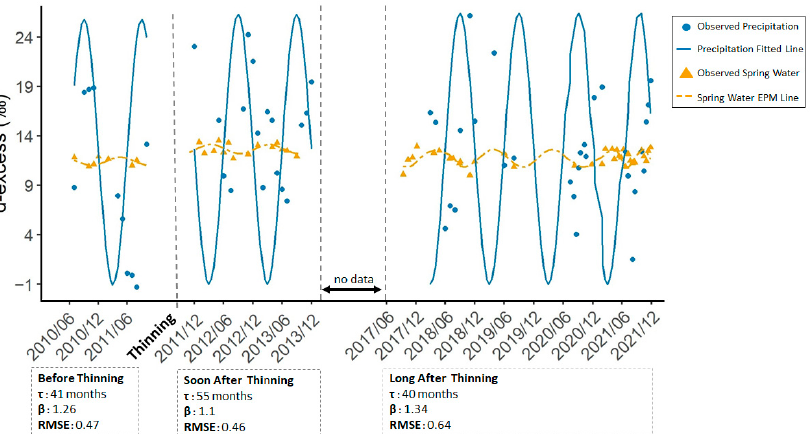
Figure 4. Long-term variations in the spring water d-excess and the mean transit time (MTT) analysis flow determined by applying the EPM to fit the observed data. The final τ and β parameters and the root mean square error (RMSE) of each study period are shown in their corresponding boxes under the graph. According to the τ results from the model (Figure 4), the MTT increased after forest thinning was performed. Six years later, the MTT decreased again. We understand that with a higher infiltration soon after thinning, older groundwater mixed with the younger and was pushed out of the underground system. The MTT during the final study period was close to the SF 6 apparent age. The lowest RMSE was 0.45 in the “soon after thinning” period. 3.4. Long-Term Hydrological Processes in the Study Area Based on the MTT and the average annual spring water discharge, we determined the storage volume of the catchment over time (Equation (6)). As shown in Figure 5, the average volume of the catchment increased from 676 mm to 1171 mm 1–2 years after the forest was thinned. Approximately six years later, the storage volume was decreased to 588 mm. Figure 5. Schematic diagram illustrating hydrological processes in the study area during the “before thinning” (2010–2011), “soon after thinning” (2011–2013), and “long after thinning” (2017–2021) study periods. Arrow lengths demonstrate changes in the amount of water loss and infiltration, with the precipitation arrow remaining stable. The water table line indicates fluctuations in groundwater storage. The MTT and volume are shown below the diagram.